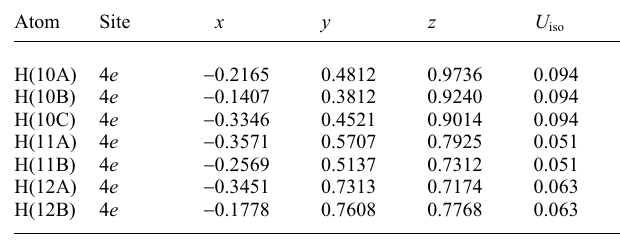
Table 3. Atomic coordinates and displacement parameters (in Å 2 ) .